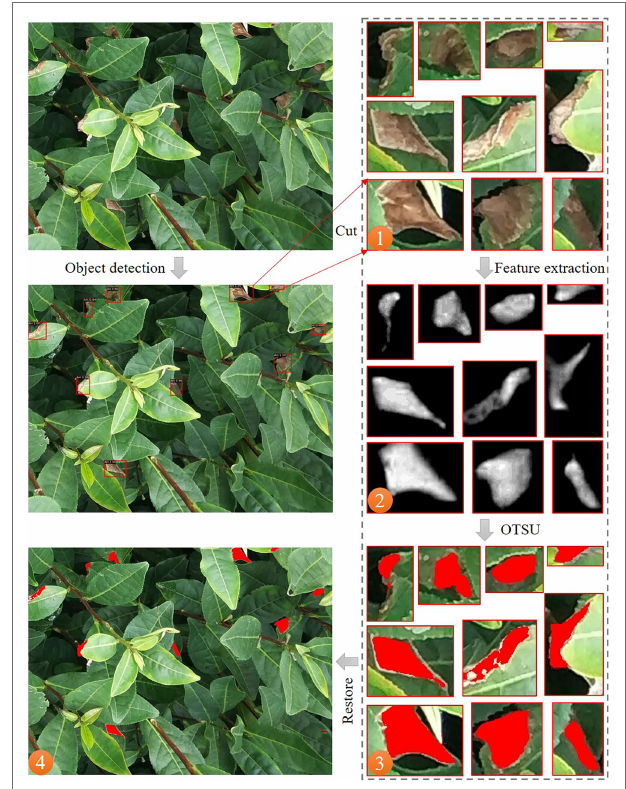
FIGURE 5 | The schematic diagram of the tea plant stress segmentation method at the canopy